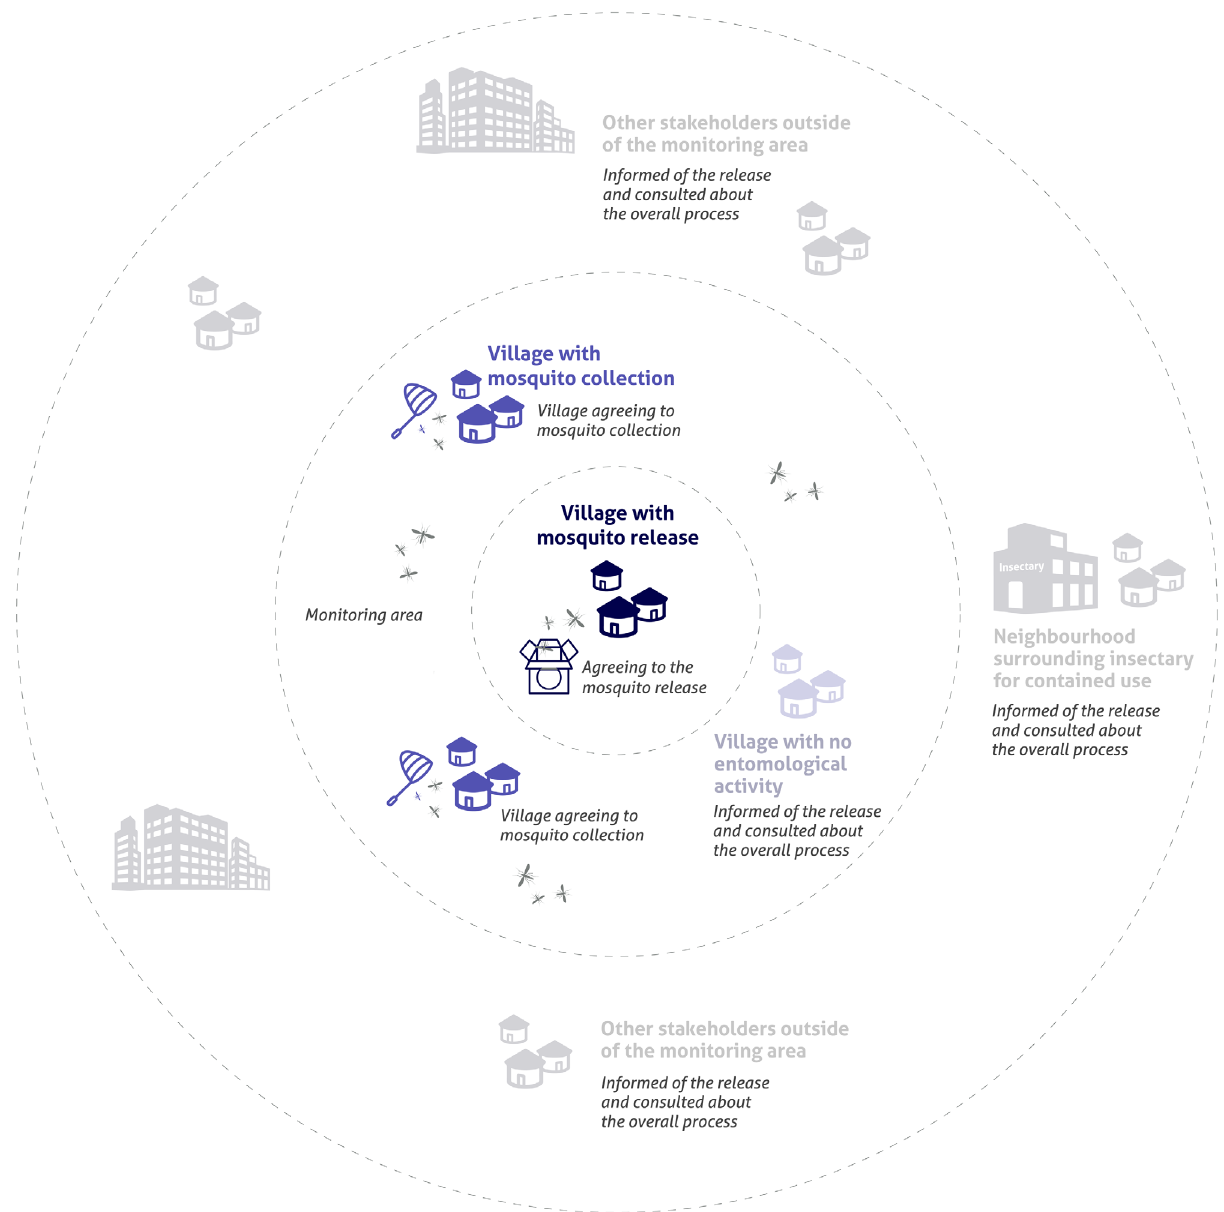
Figure 1. Areas of differing stakeholder